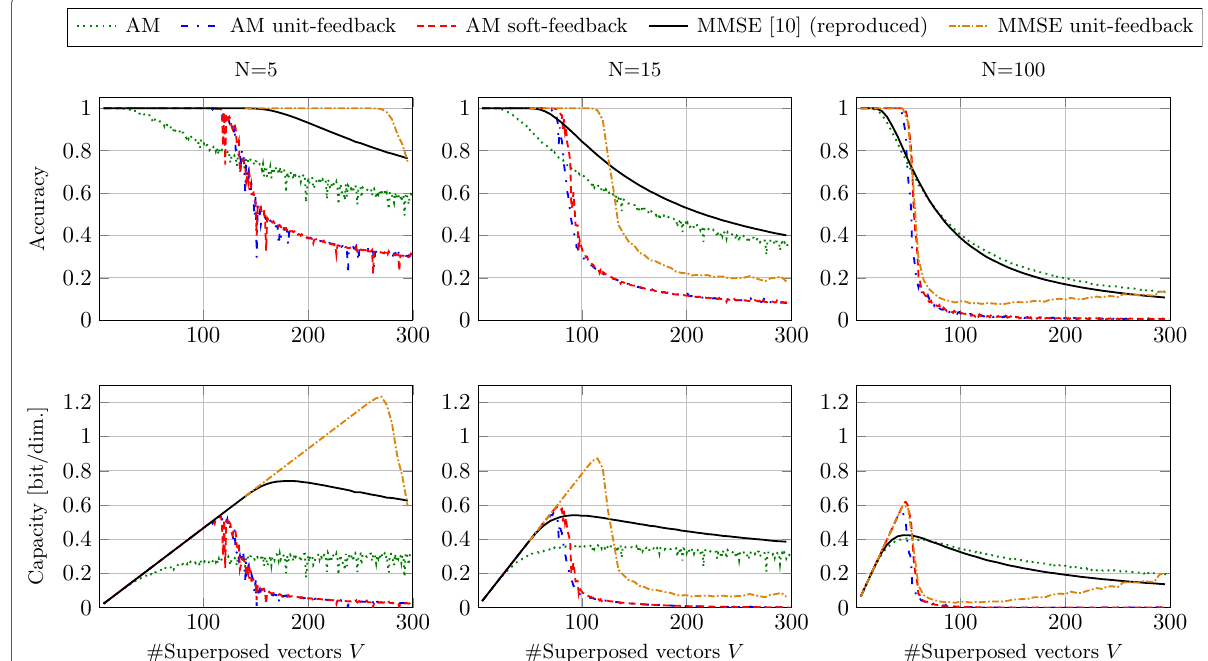
.] m d i / t b i [ y i t a c p a C